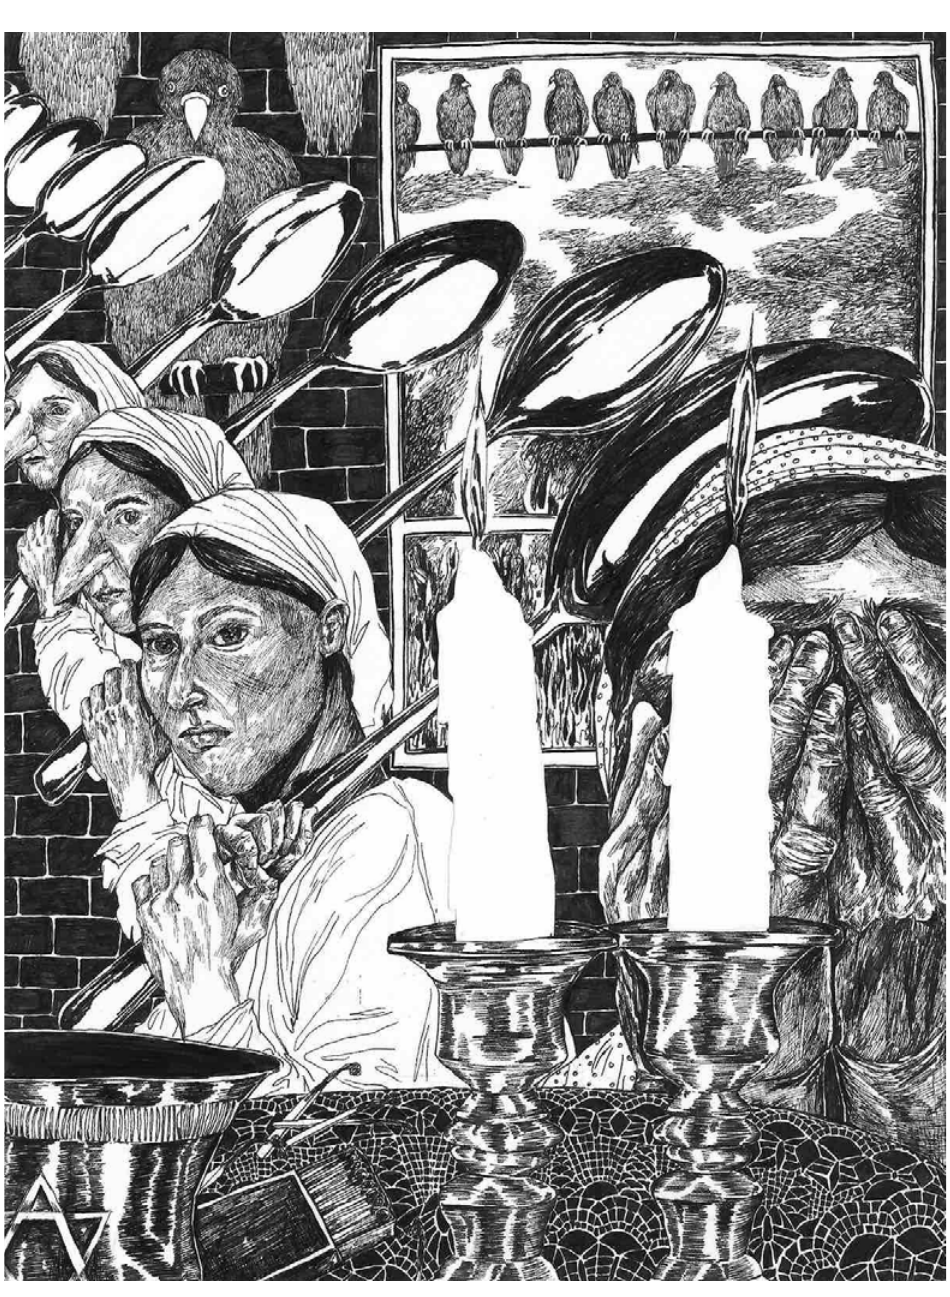
Rosabel Rosalind Kurth-Sofer, Exodus VI , 2018. Pen and ink on paper. 9x11